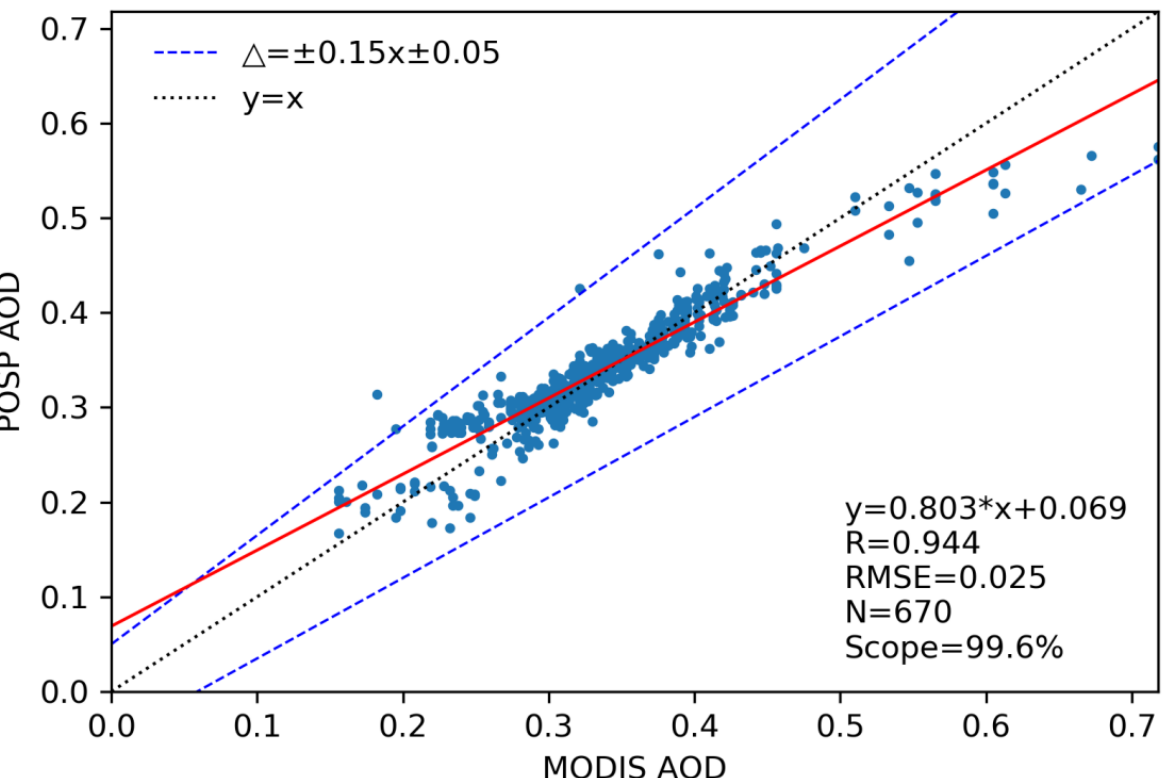
Figure 9. The scatter plot of POSP AOD inversion results against MODIS products (4 May 2022).